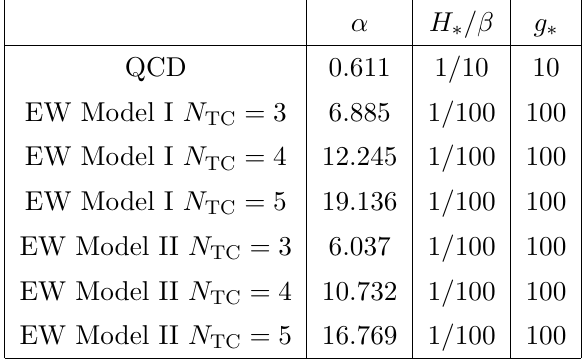
Table 2 . Parameters (cid:11) , H (cid:3) =(cid:12) and g (cid:3) used to calculate the GWs in the holographic QCD model and holographic EW model, respectively.